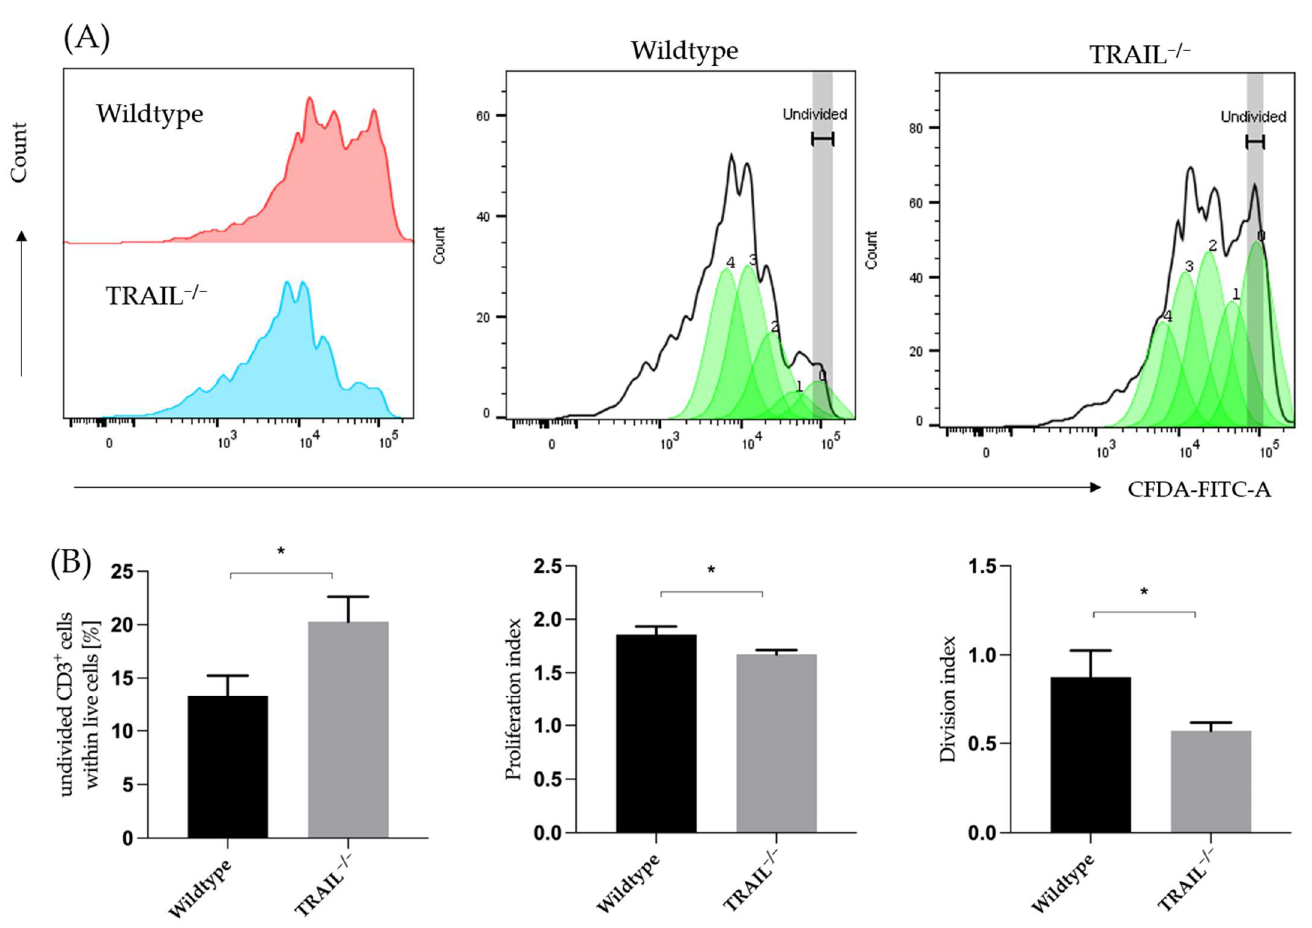
Figure 10. CD3 + T-cell proliferation in TRAIL −/− and wildtype mice. ( A ) FACS histogram of proliferation peaks. ( B ) Cumulative percentage of undivided CD3 + T-cells, proliferation index, and division index of CD3 + T-cells from of TRAIL −/− mice versus wildtype C57BL/6 mice ( t -test, n = 6–8, * p < 0.05). Graphs show mean ± SD.